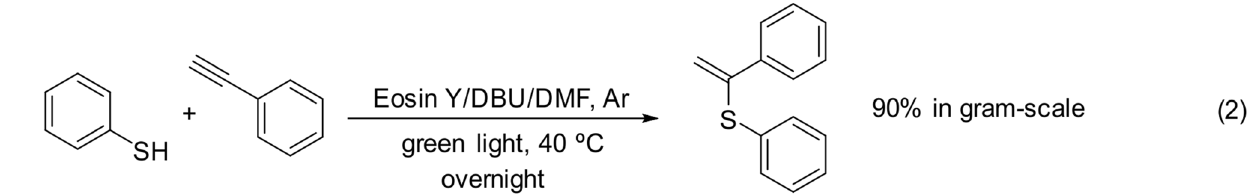
Figure 4. Studied Eosin Y-mediated photochemical thiol-yne coupling